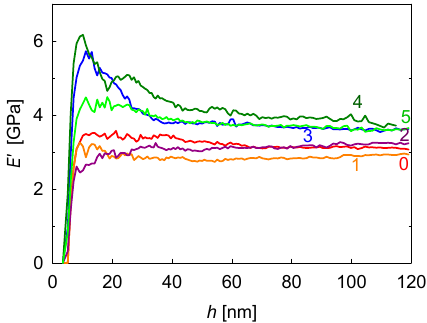
Figure 2. Storage modulus, E ′ , measured as a function of penetration depth, h, for the first six indentations of the scanning line of Figure 1. Numbers indicate the distance (in µm) from each indent to the starting point.